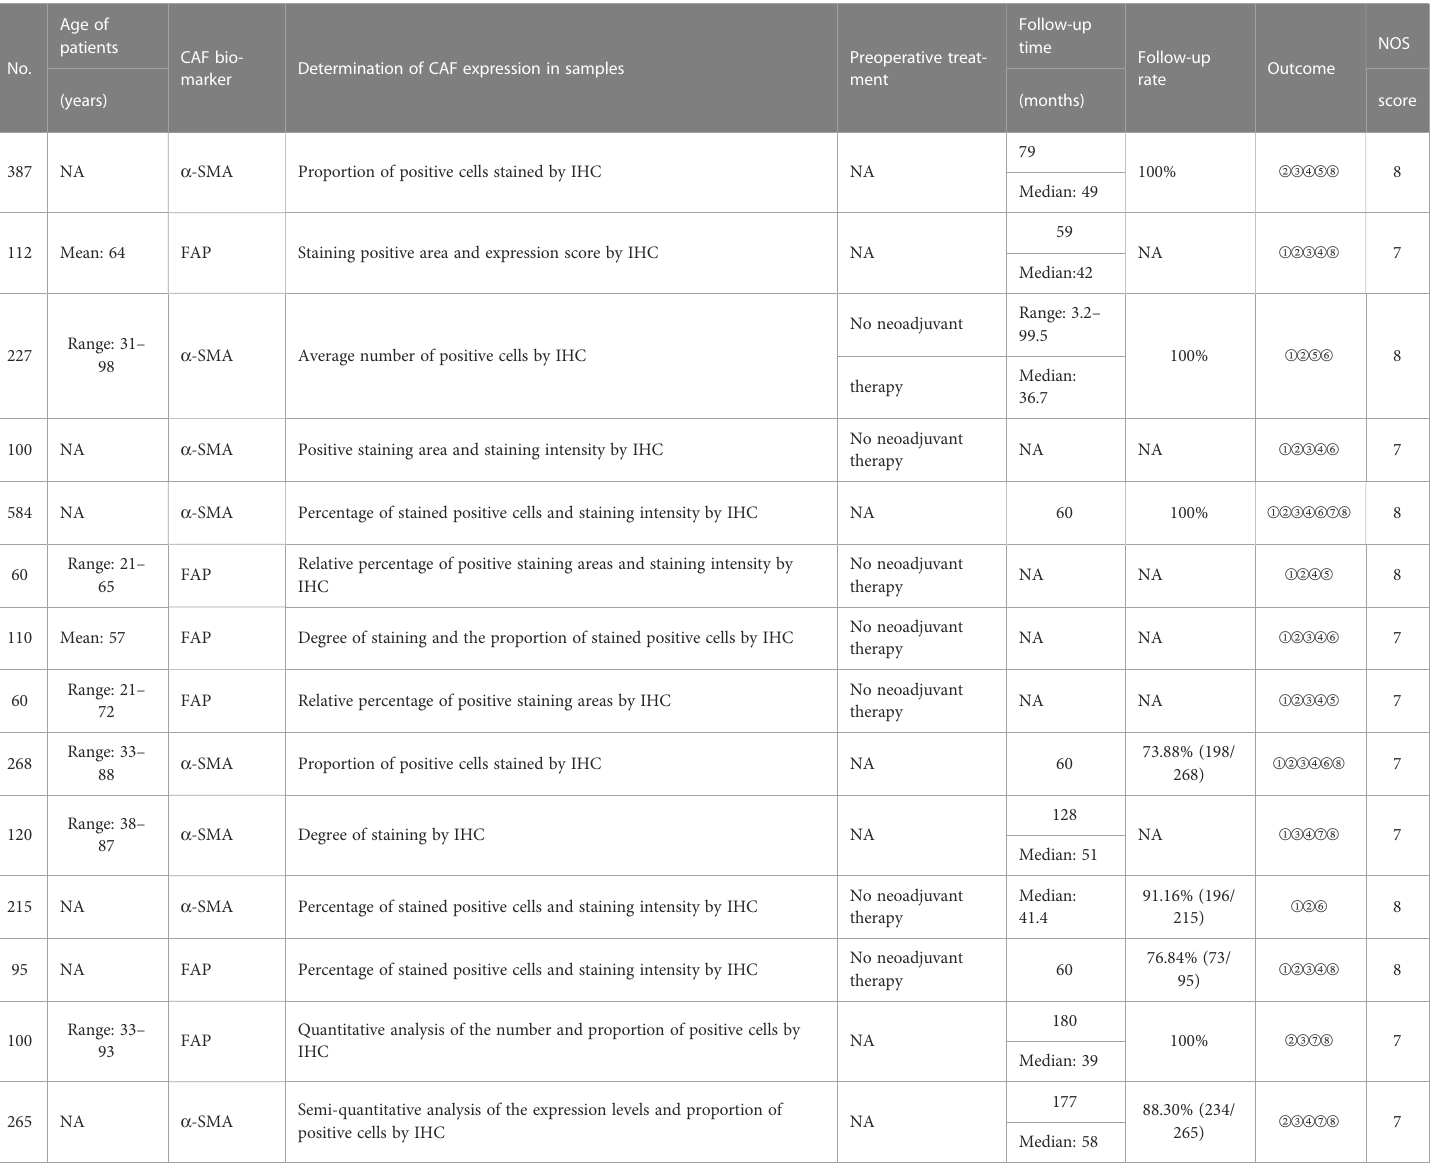
TABLE 1 Characteristics of studies included in the